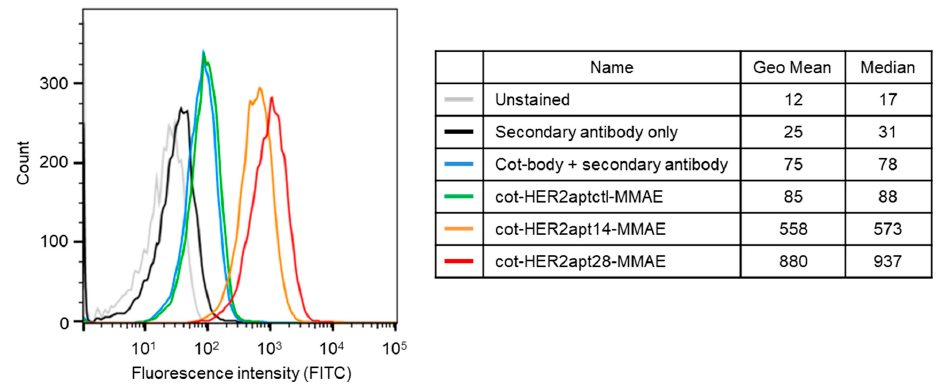
Figure 2. Flow cytometric analysis of cot-HER2apt-MMAEs. NCI-N87 cells (3 × 10 5 ) were incubated with 100 pmoL of cot-HER2aptctl-MMAE, cot-HER2apt14-MMAE, or cot-HER2apt28-MMAE at 4 °C. The cells incubated with 100 pmoL of fluorescein isothiocyanate (FITC)-labeled secondary antibody (with or without primary antibody) served as negative controls. Fluorescence was measured by using a FACSVerse flow cytometer.